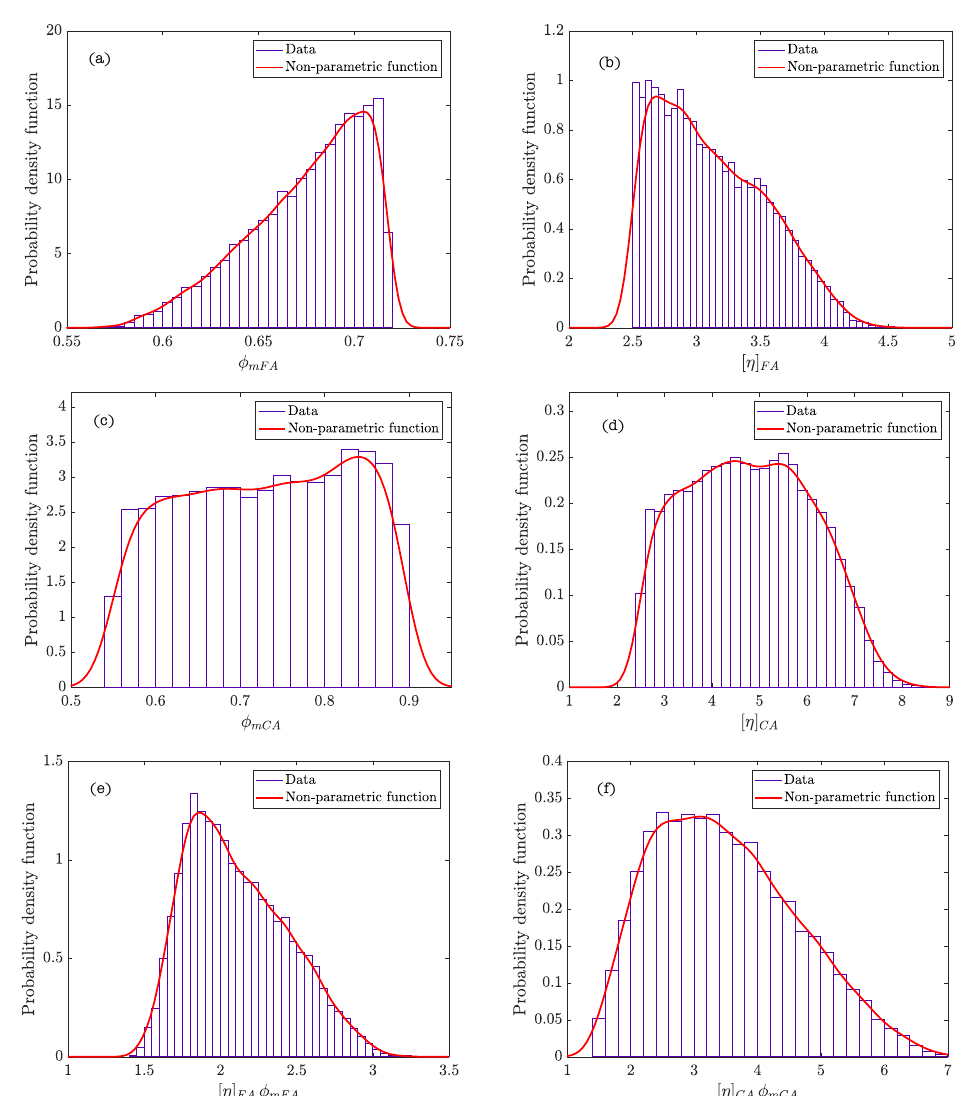
Figure 11. Probability density functions of the parameters of the SCC phases in Esmaeilkha- nian et al. [40]: ( a ) φ mFA ; ( b ) [ η ] FA ; ( c ) φ mCA ; ( d ) [ η ] CA ; ( e ) [ η ] FA φ mFA ; and ( f ) [ η ] CA φ mCA